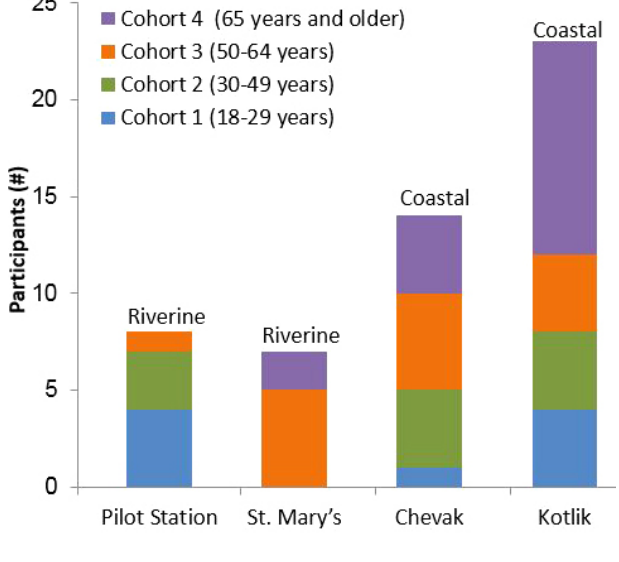
Fig. 2 . Interview participants by community, age, and